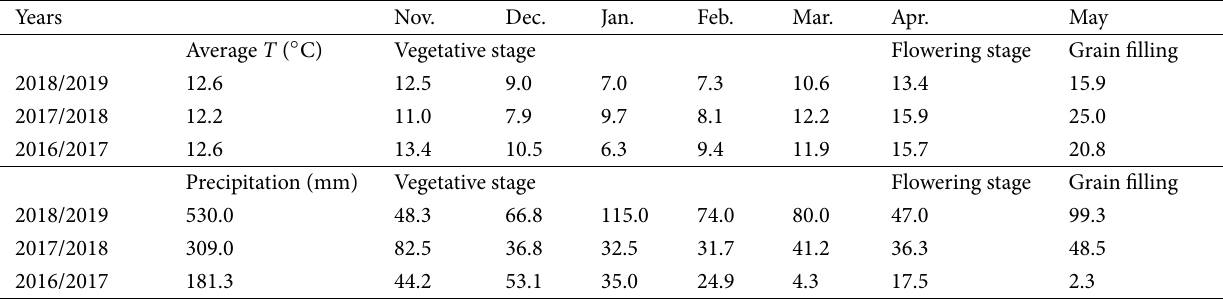
Table 2 Descriptions of the environmental conditions during three evaluated cropping seasons.